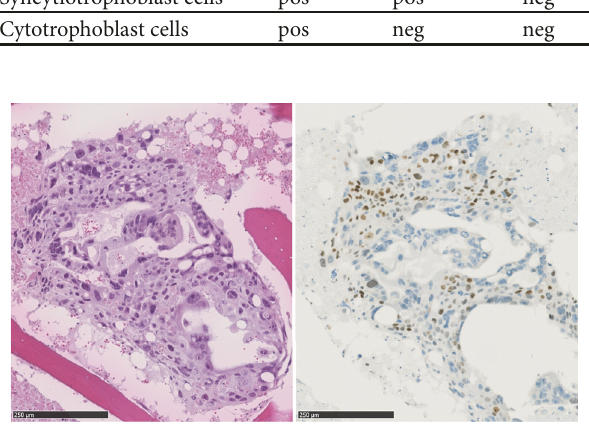
Figure 1: Left: HE stained section of choriocarcinoma metastasis in L2. Right: the same section stained immunohistochemically for p63. Positive reaction (brown) in the nuclei of the cytotrophoblast cells.